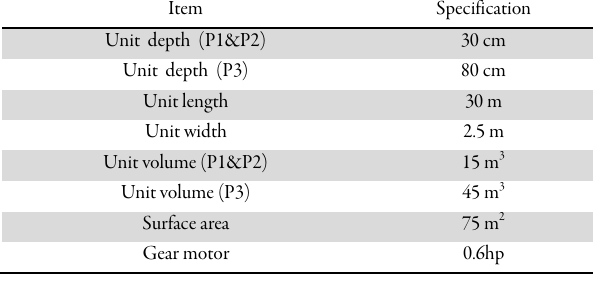
Table 3. Technical specifications of different open ponds used Item